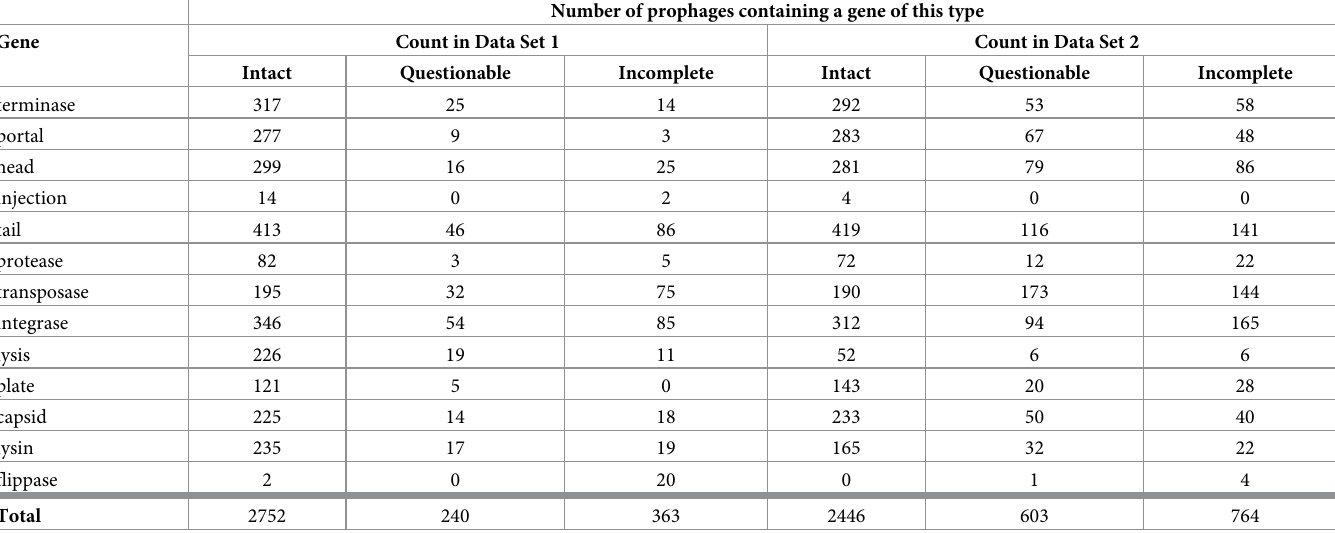
Table 1. The genetic repertoire of prophages in Data Set 1 and Data Set 2.